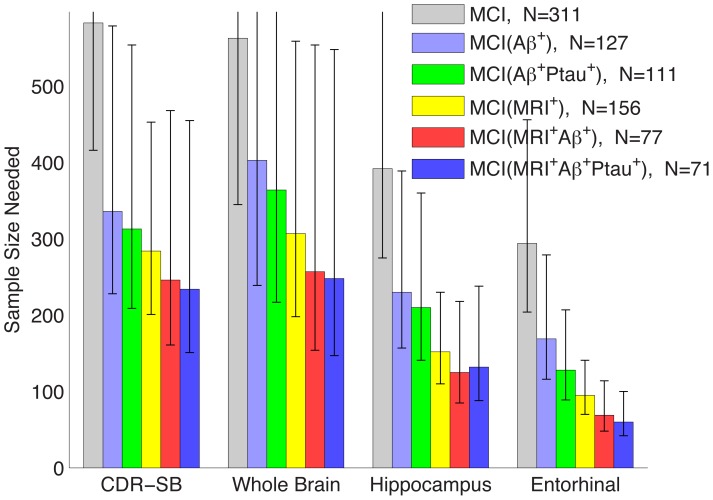
Estimated sample sizes, per arm, to detect a 25% reduction in annual rate of change in MCI participants under several enrichment strategies, relative to the annual rate of change in amyloid-negative stable HCs, at the p<0.05 level with 80% power assuming a 24 month trial with scans every six months.Sample sizes are estimated using a linear mixed effects model with fixed intercepts (no relative change at baseline) and random slopes applied to all data available up through 36 months. Error bars show the 95% confidence intervals. N is the number of participants. All numerical values are shown Table 3; p-values for comparisons are in Tables 4 and 5.